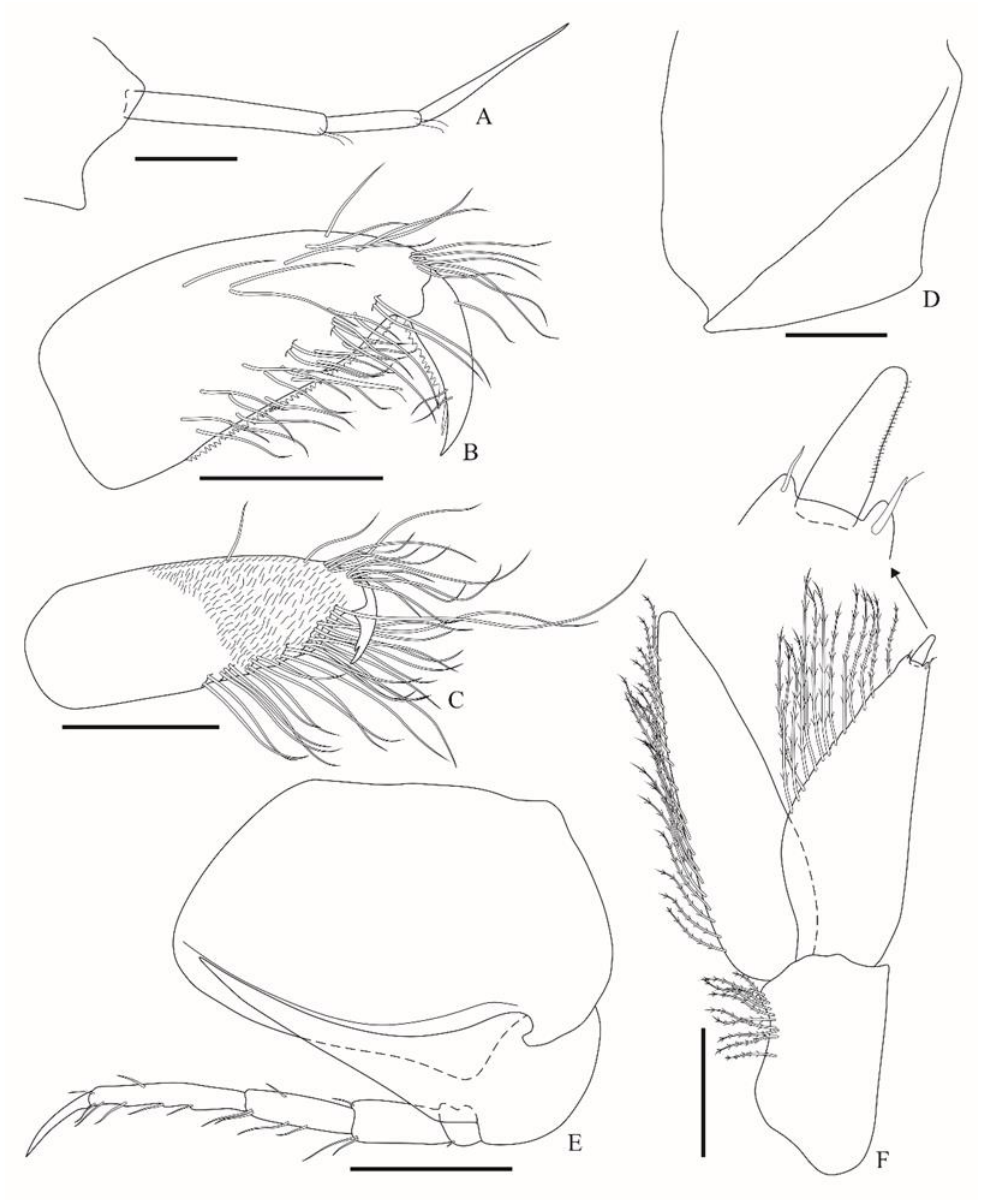
Figure 7. Cyphocaris boecki sp. nov., juvenile paratype, 17 mm (MOUFPE 20069). ( A ) Accessory flagellum of antenna 1; ( B ) propodus and dactylus of gnathopod 1; ( C ) propodus and dactylus of gnathopod 2; ( D ) epimeral plate 1; ( E ) pereopod 5; ( F ) uropod 3. Scale bars: 0.3 mm for ( A – C ); 0.5 mm ( D , F ); 1 mm for ( E ).